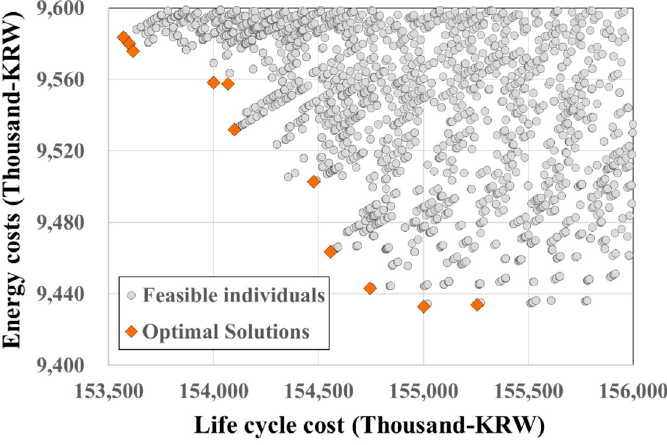
Figure 15. Pareto ‐ Optimal Solutions in daytime load pattern.